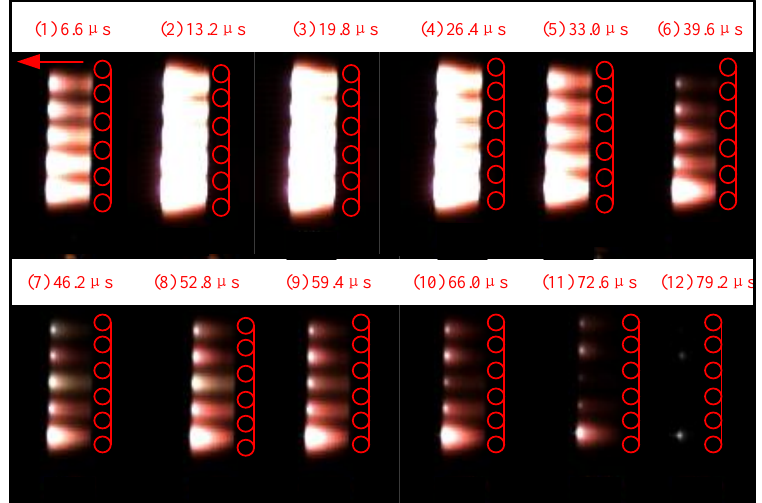
Figure 11 Arc extinction process in the optimized multi-chamber structure. Figure 11. Arc extinction process in the optimized multi-chamber